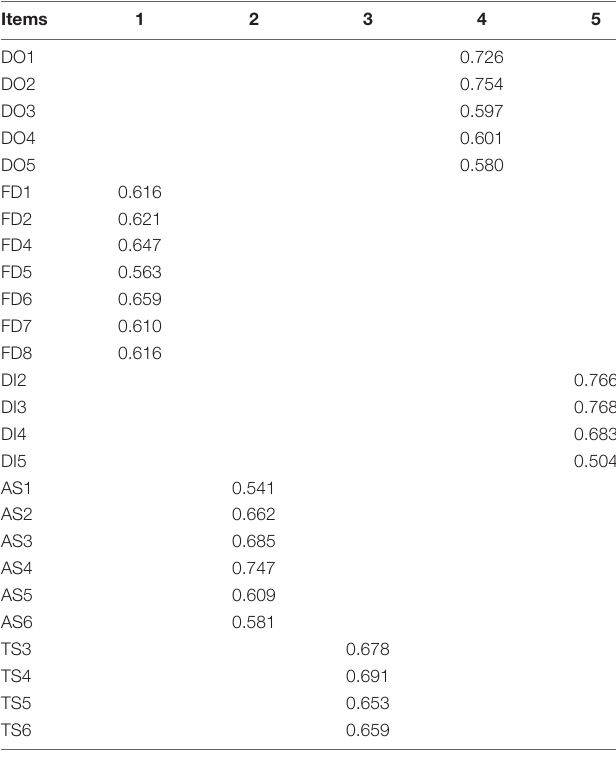
TABLE 2 | Teaching presence measurement factor analysis (N Sample 1 = 204).